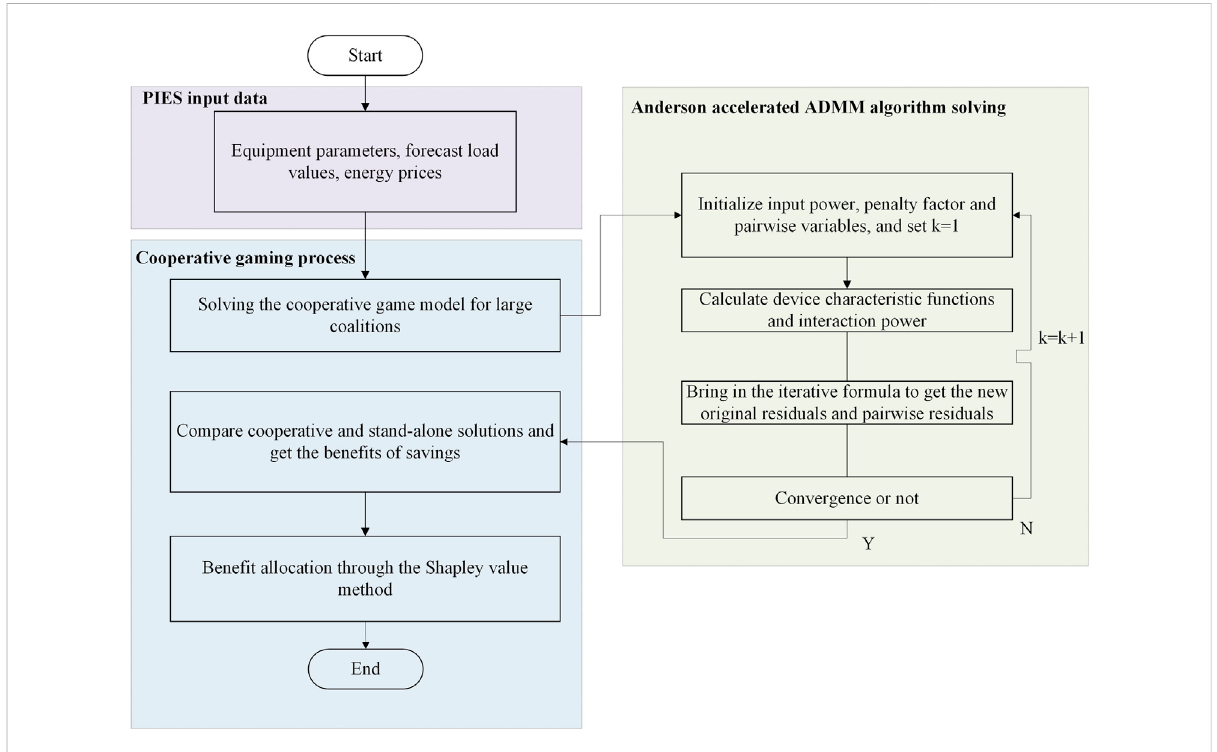
FIGURE 3 Optimized scheduling solution